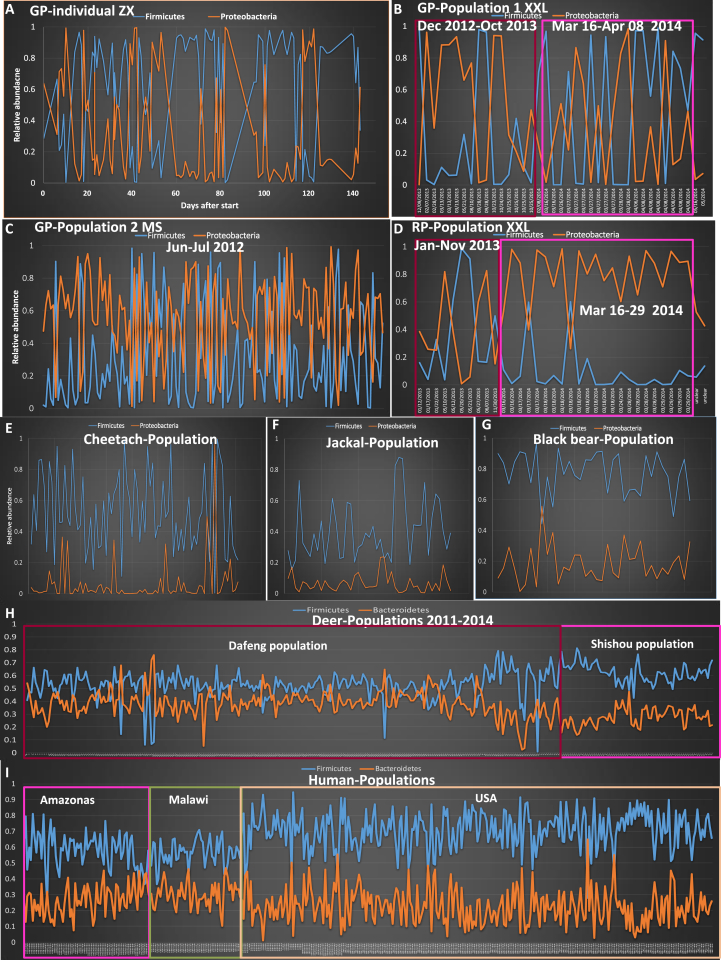
The variation in dominant gut microbial groups (phylum level) among the giant panda and red panda, Père David's deer, cheetah, jackal, black bear, and human. The distribution of dominant gut bacterial phyla in the giant panda individual-Zhangxiang ZX (A), Xiaoxiangling XXL giant panda population (B), Minshan MS giant panda population (C), Xiaoxiangling red panda population (D), Cheetach population (Menke et al., 2014) (E), Jackal population (Menke et al., 2014) (F), black bear population (Song et al., 2017) (G), Père David's deer (H) and humans (Yatsunenko et al., 2012) (I). Y-axis was the relative abundance. X-axis was each sample. Blue line: Firmicutes. Brown line: Proteobacteria.